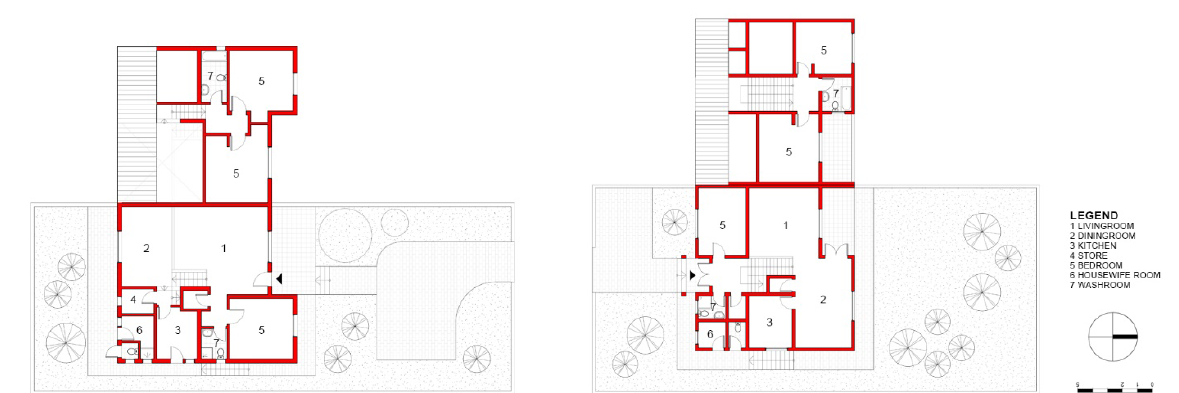
Figure 32. The Umudugudu Kigali 2020: Ground and first floor twin house types 4 and 3. Drawing by Manlio Michieletto.